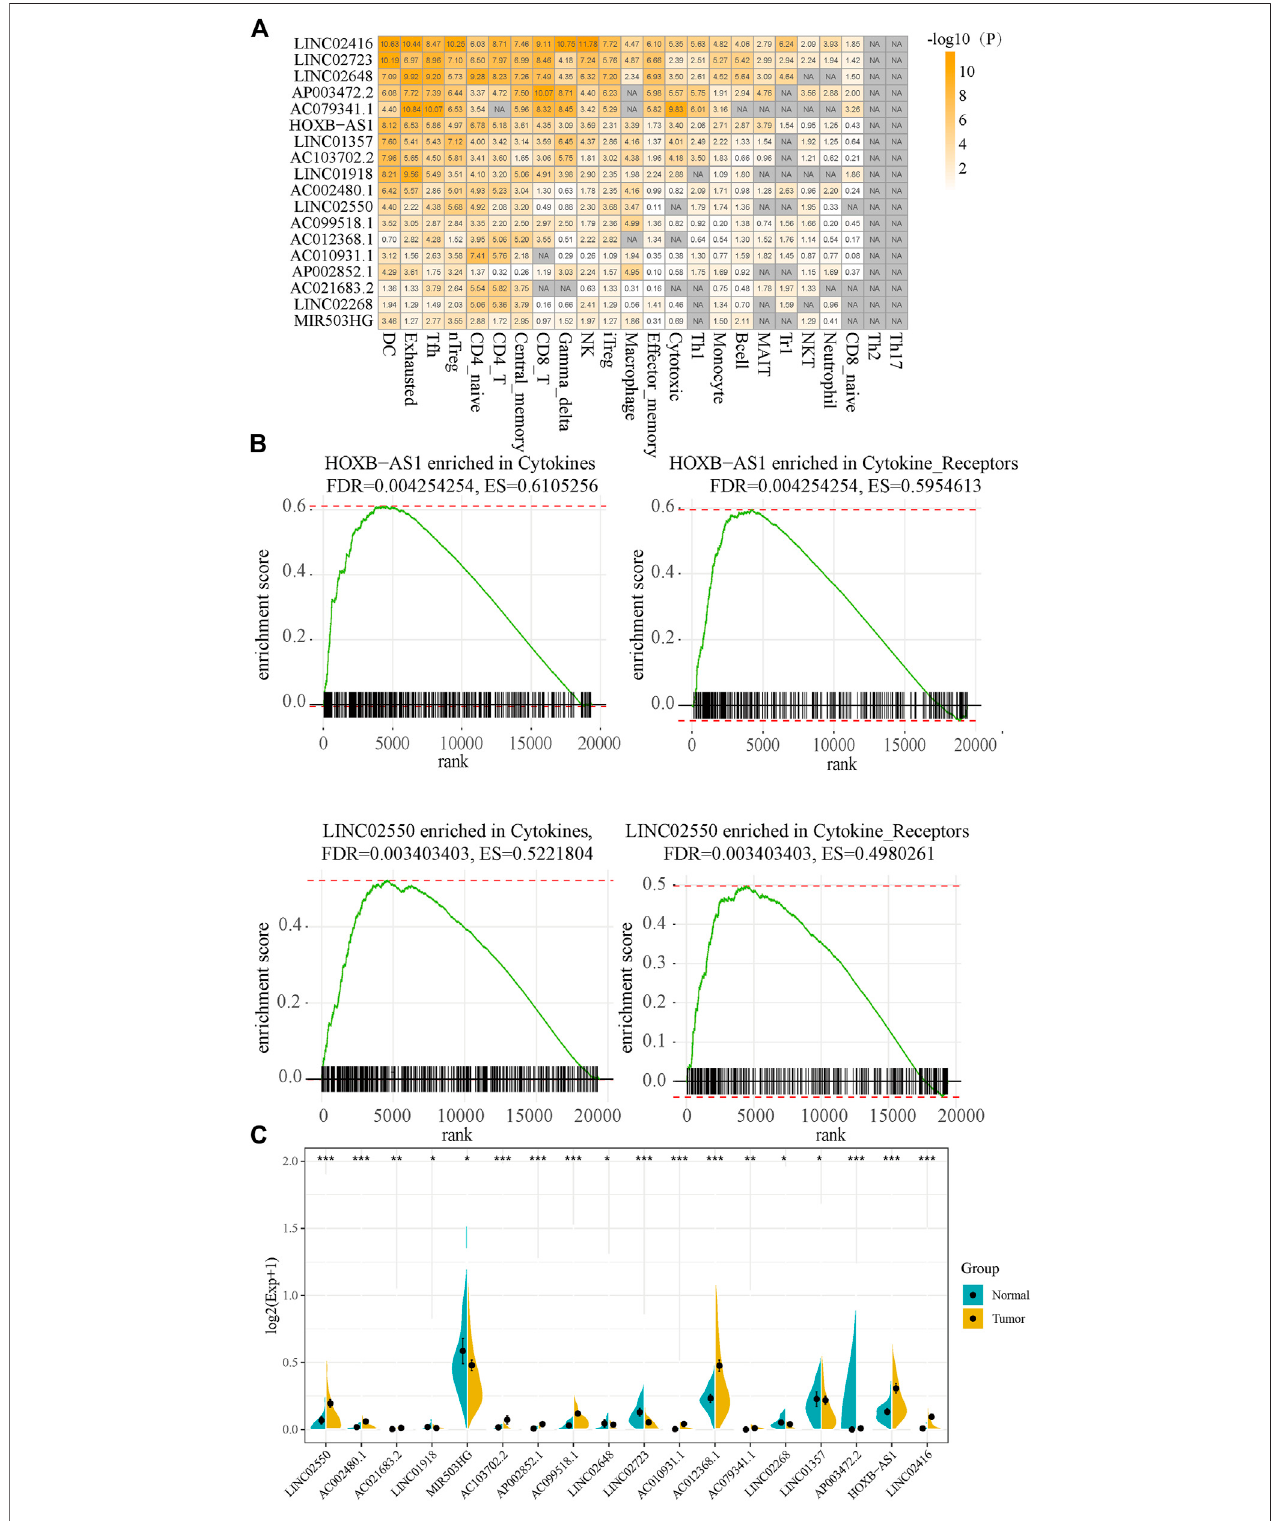
FIGURE 6 | The functional analysis of dysregulated immune lncRNA. (A) . Enrichment signi fi cance of dysregulated immune lncRNAs and immune cells. (B) HOXB- AS1 and LINC02550 are enriched for cytokines and cytokine_self pathways. (C) The expression of 18 lncRNAs in cancer and adjacent cancer.